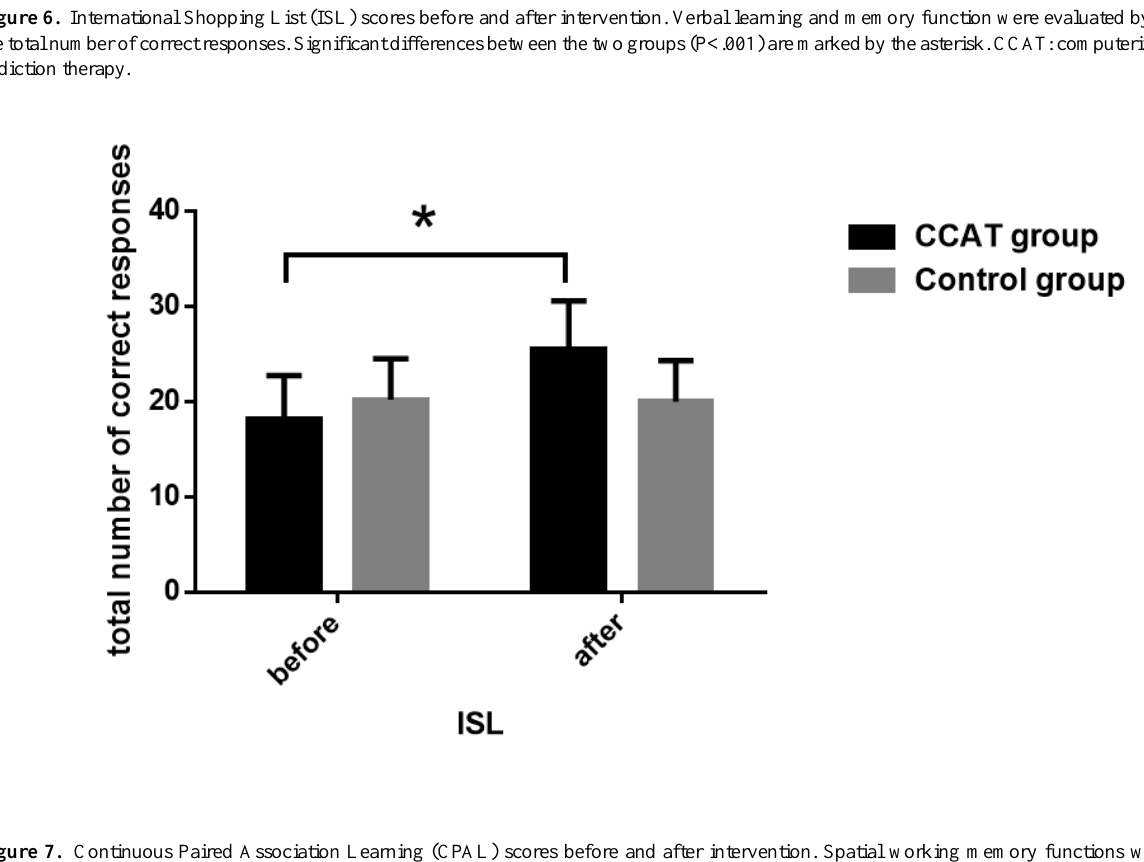
Figure 7. Continuous Paired Association Learning (CPAL) scores before and after intervention. Spatial working memory functions were reflected through the total number of errors in the CPAL. Significant differences between the two groups (P=.01) are marked by the asterisk. CCAT: computerized cognitive addiction